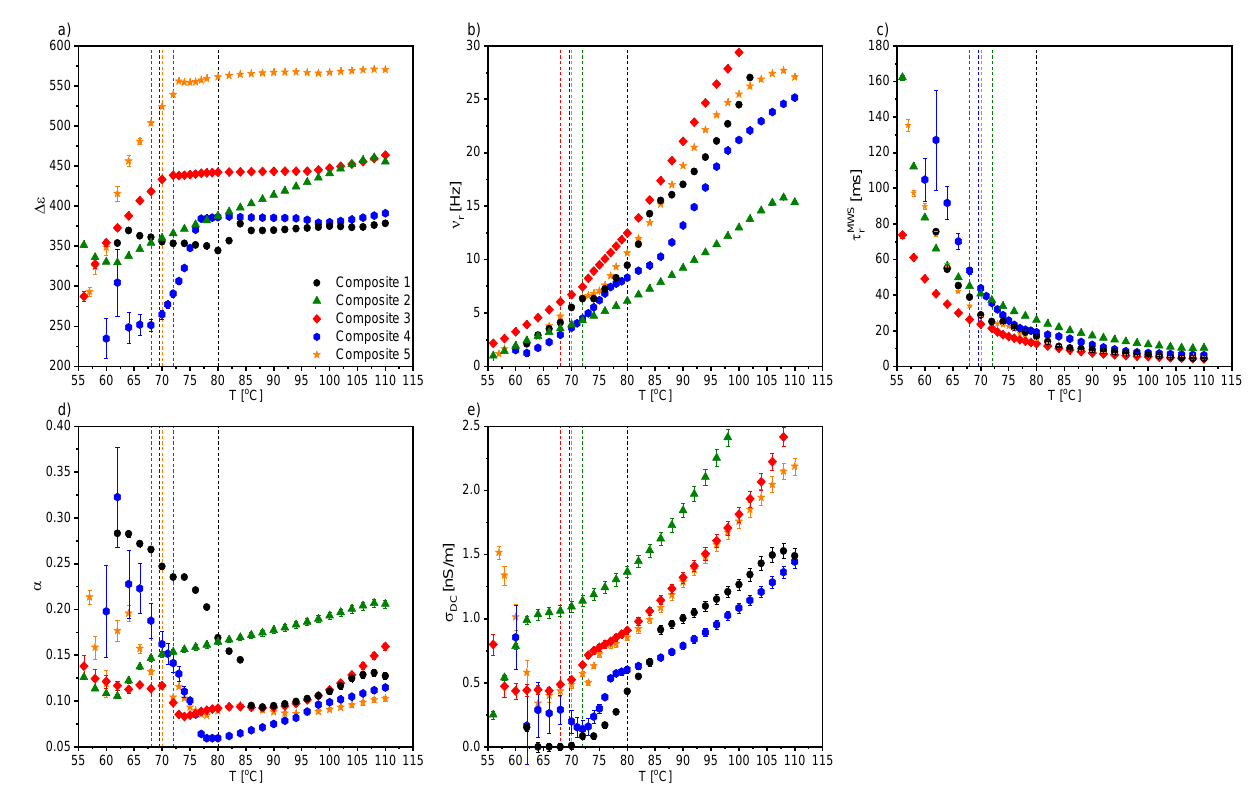
Figure 13. Temperature dependencies of the dielectric increment, ∆ ε ( a ); relaxation frequency, ν r ( b ); relaxation time ( c ); the distribution parameter of relaxation time, α ( d ) of the Maxwell–Wagner–Sillars process; as well as DC conductivity ( e ) for Composites 1–5. The legend in graph ( a ) is the same for all graphs. The vertical dashed lines represent the SmA*–SmC* phase transition temperature (during cooling).